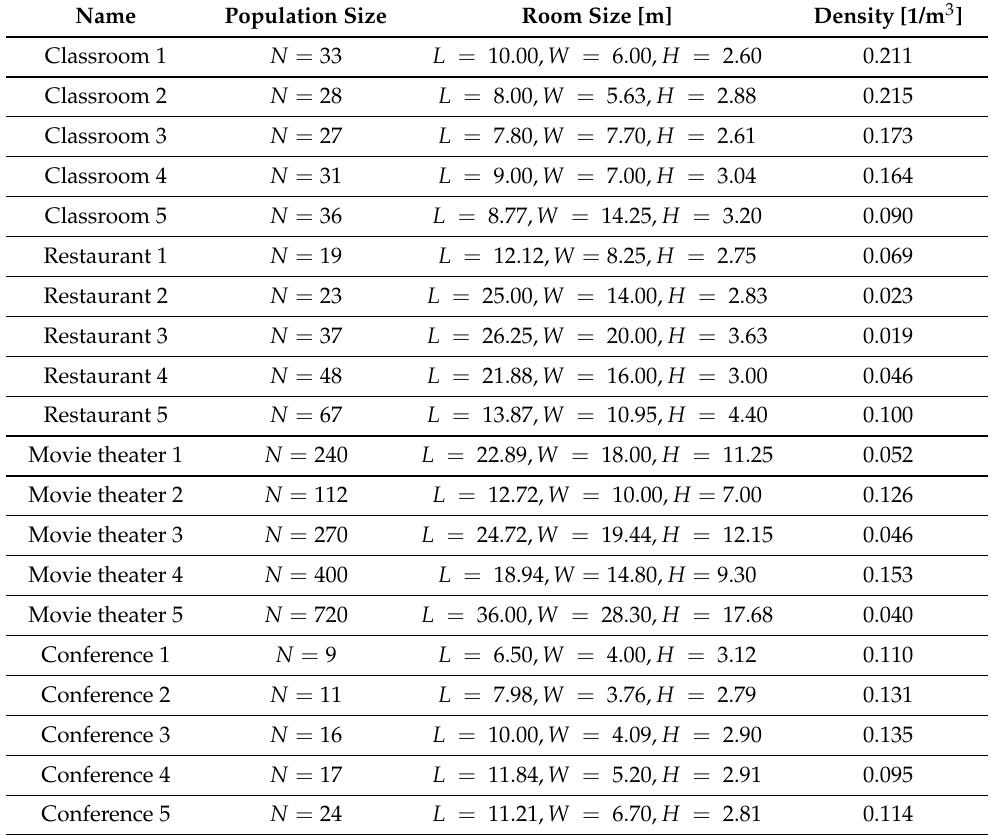
Table 2. The different room types used in the experiments with a qualitative description of the population size and the room’s dimensions in